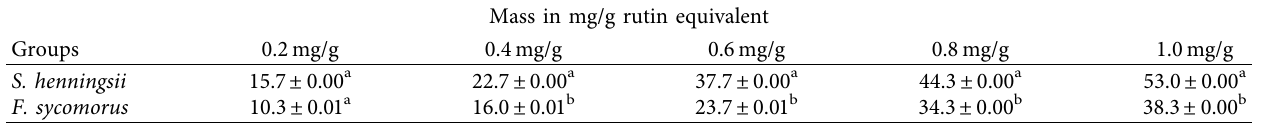
Table 3: Total favonoid content of DCM extracts of S. henningsii and F. sycomorus .